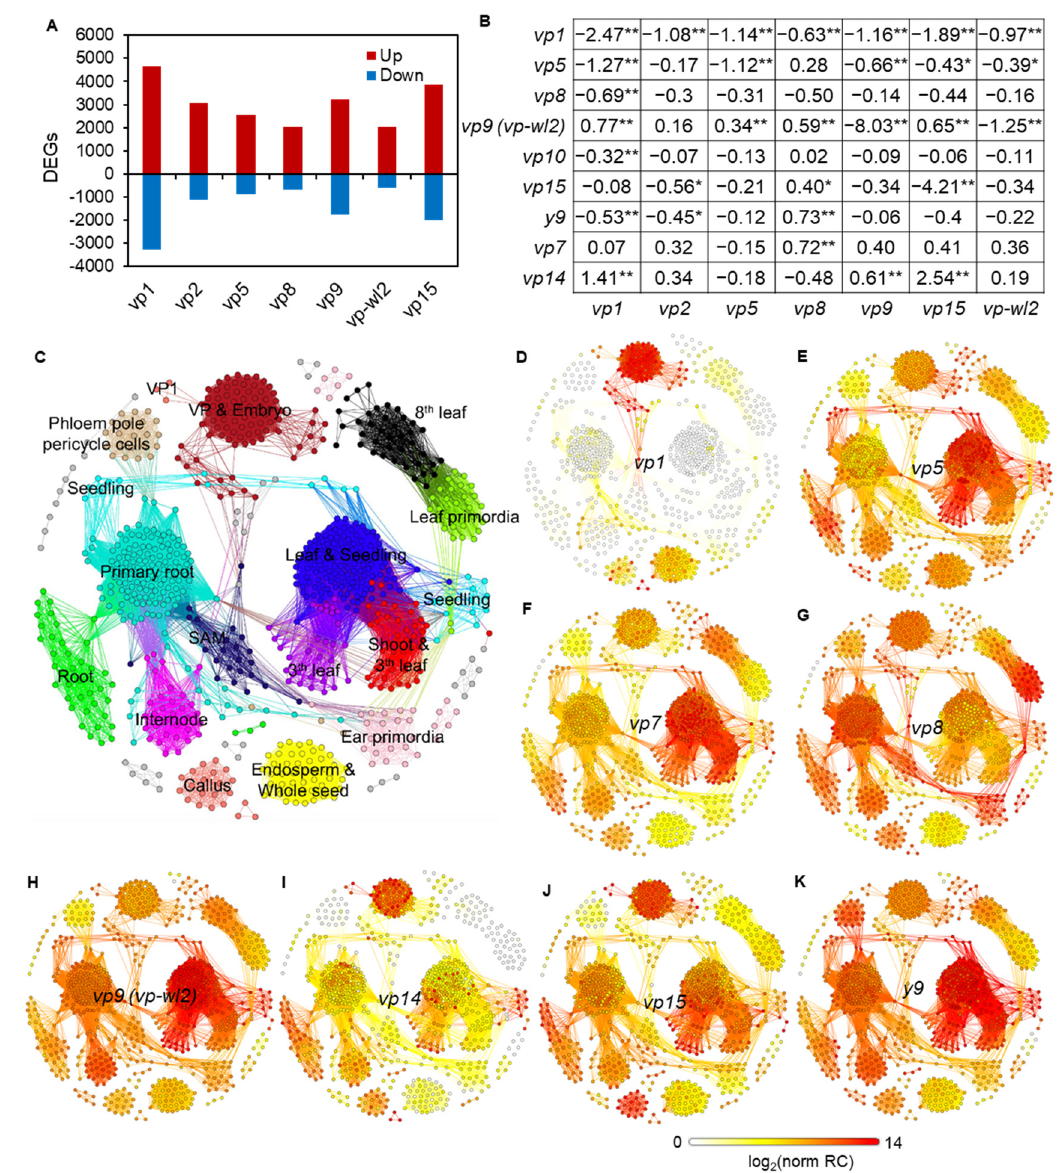
Figure 2. Expression pattern of vivipary genes. ( A ) Number of DEGs in seven comparison groups. Red bars represent upregulated genes in mutants, and blue bars represent downregulated genes in mutants. The DEGs were obtained by comparing the mutant to wild-type (|log 2 (fold change)| ≥ 1 and FDR < 0.05). ( B ) The reported viviparous genes were significantly expressed in at least one mutant compared with the wild-type. The data are indicated by log 2 (fold change) of mutants versus wild-types (* p -value < 0.05, ** p -value < 0.1). ( C ) Tissue-specific sample clusters based on WGCNA analysis: 739 B73 RNA-Seq samples were used to construct the network. Each individual node represented a sample and edges between nodes were determined by the connectivity strength of two samples. “VP1” stands for the vp1 mutant sample, and “VP & embryo” stands for other vivipary samples except vp1 and the embryo samples in the 739 additional publicly available data. The different colors represent different modules of B73 RNA-Seq samples. The majority tissues (>90%) of samples in each module were marked on the corresponding module. ( D – K ) Expression profile of eight different viviparous genes vp1 , vp5 , vp7 , vp8 , vp9 ( vp-wl2 ), vp14 , vp15 , and y9 in all samples. The node and edge colors from yellow to red indicate the gene expression levels from low to high. Transparent nodes and edges indicate that the gene is not expressed in this sample. The data was showed by the log 2 (normalized Read Counts (norm RC)) value.